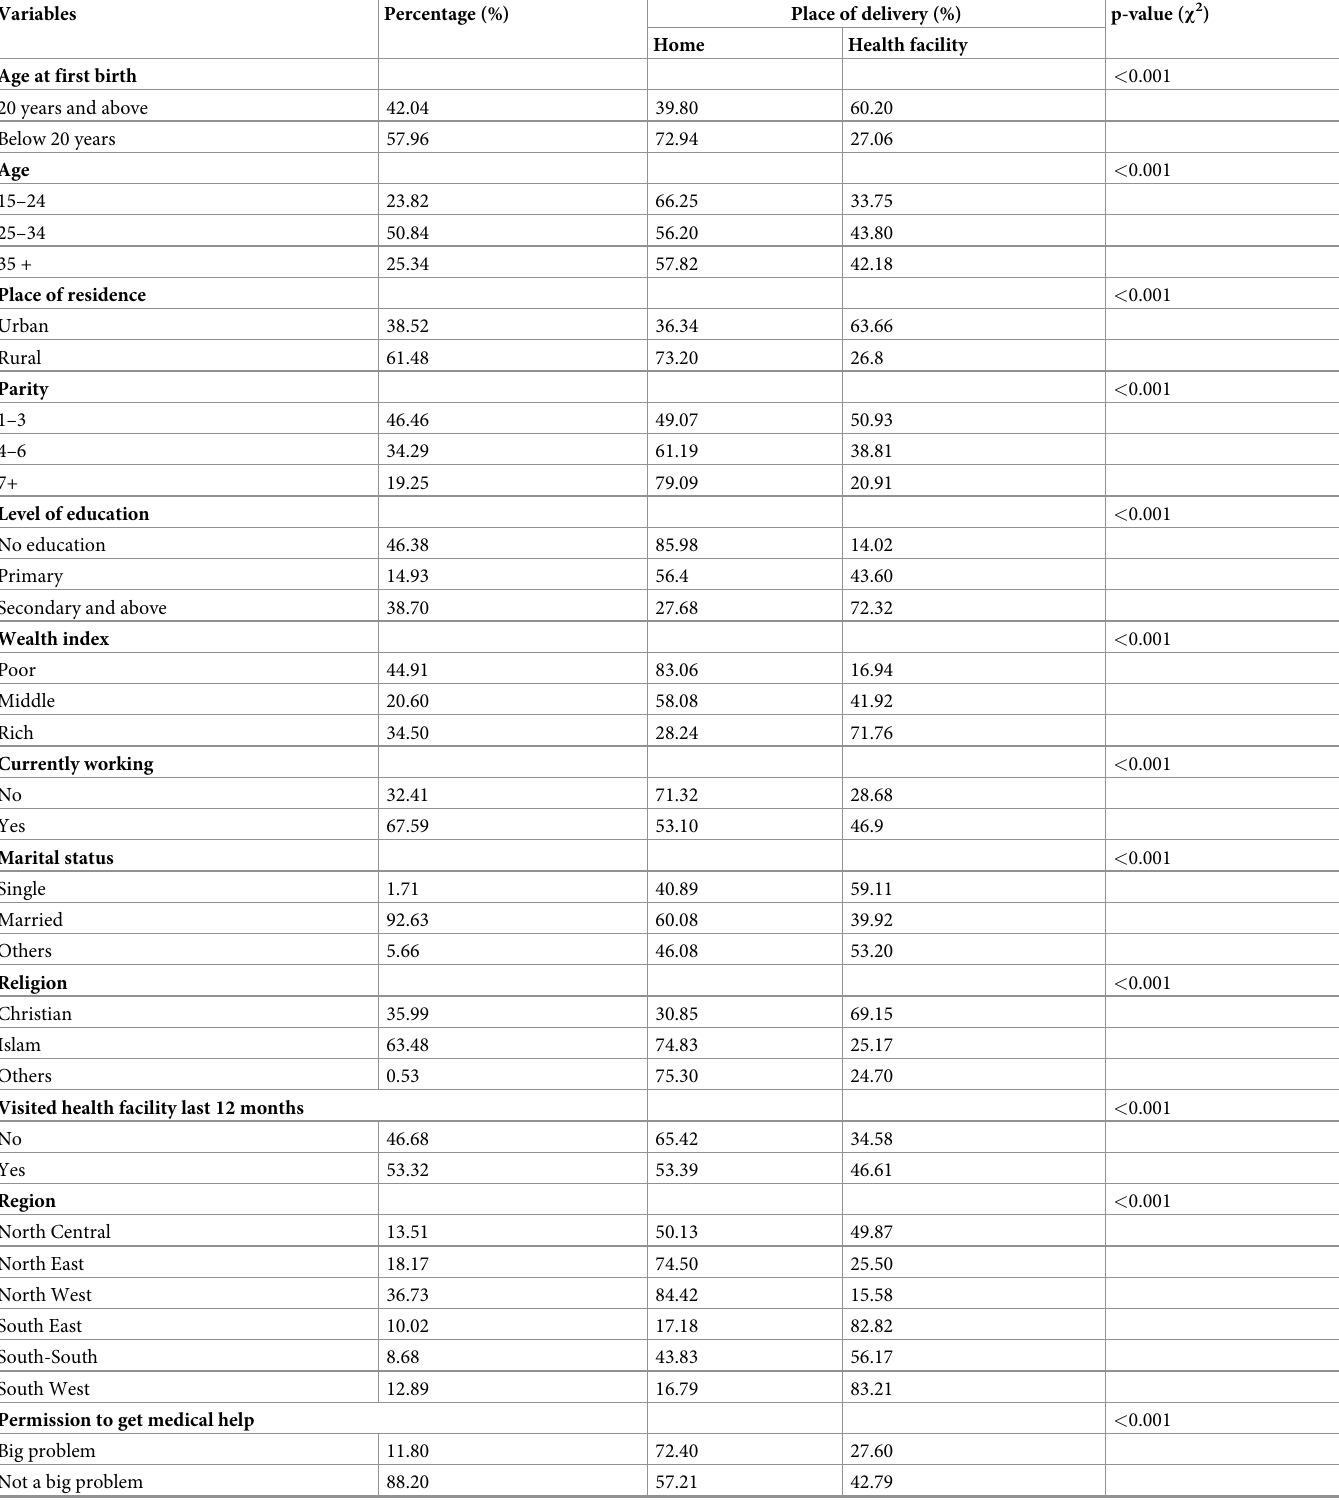
Table 1. Weighted distribution of key independent and covariate variables and place of delivery (n =